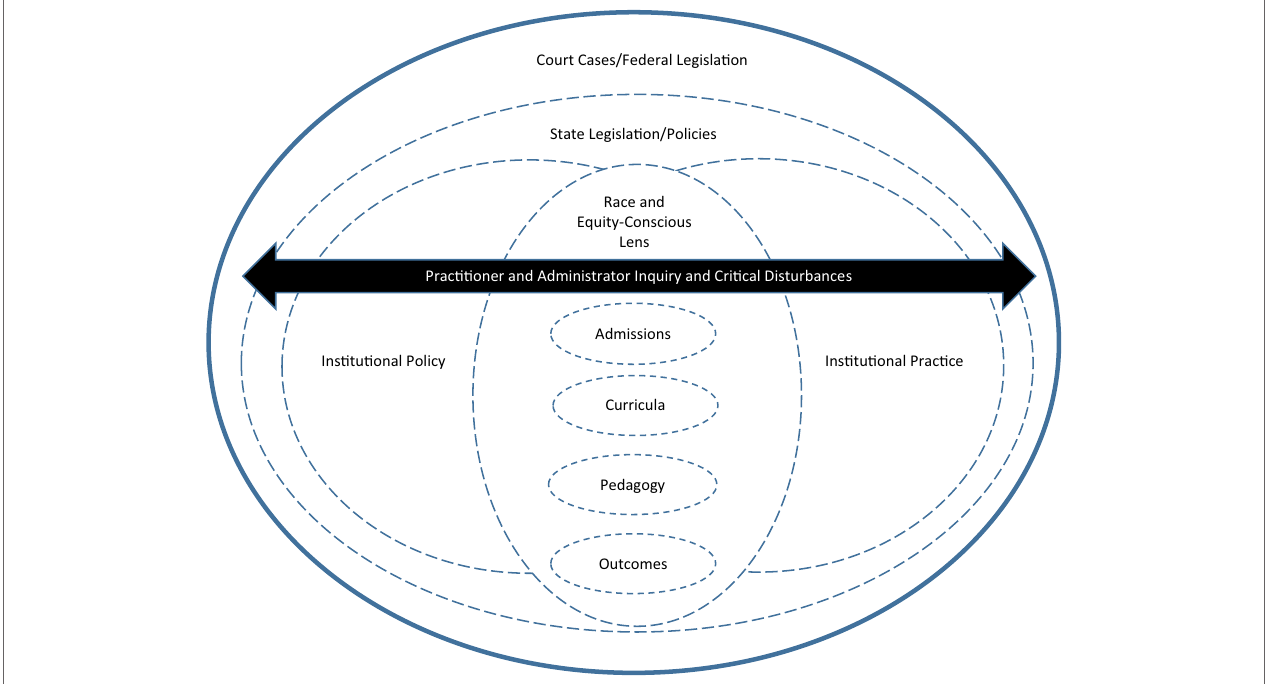
FiGuRe 1 | Holistic sociocultural inquiry-based admissions